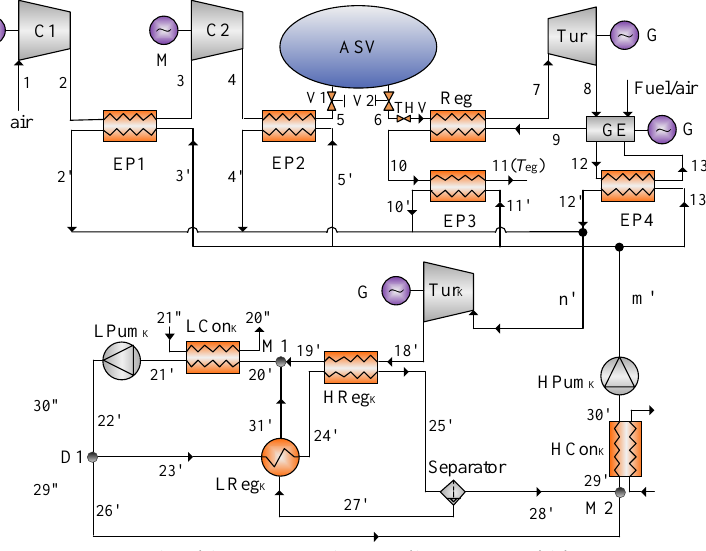
Figure 2. Schematic diagram of the ORC-CAES system.